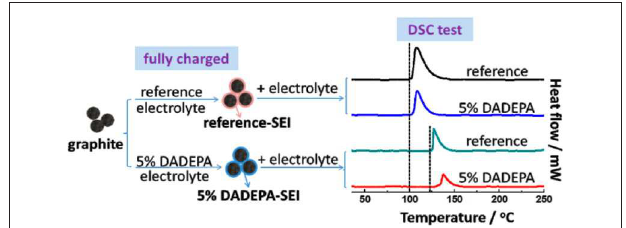
FIGURE 2 | DSC curves of fully charged graphite in reference electrolytes with and without DADEPA. Reprinted with permission from Cao et al. (2013). Copyright (2013) American Chemical